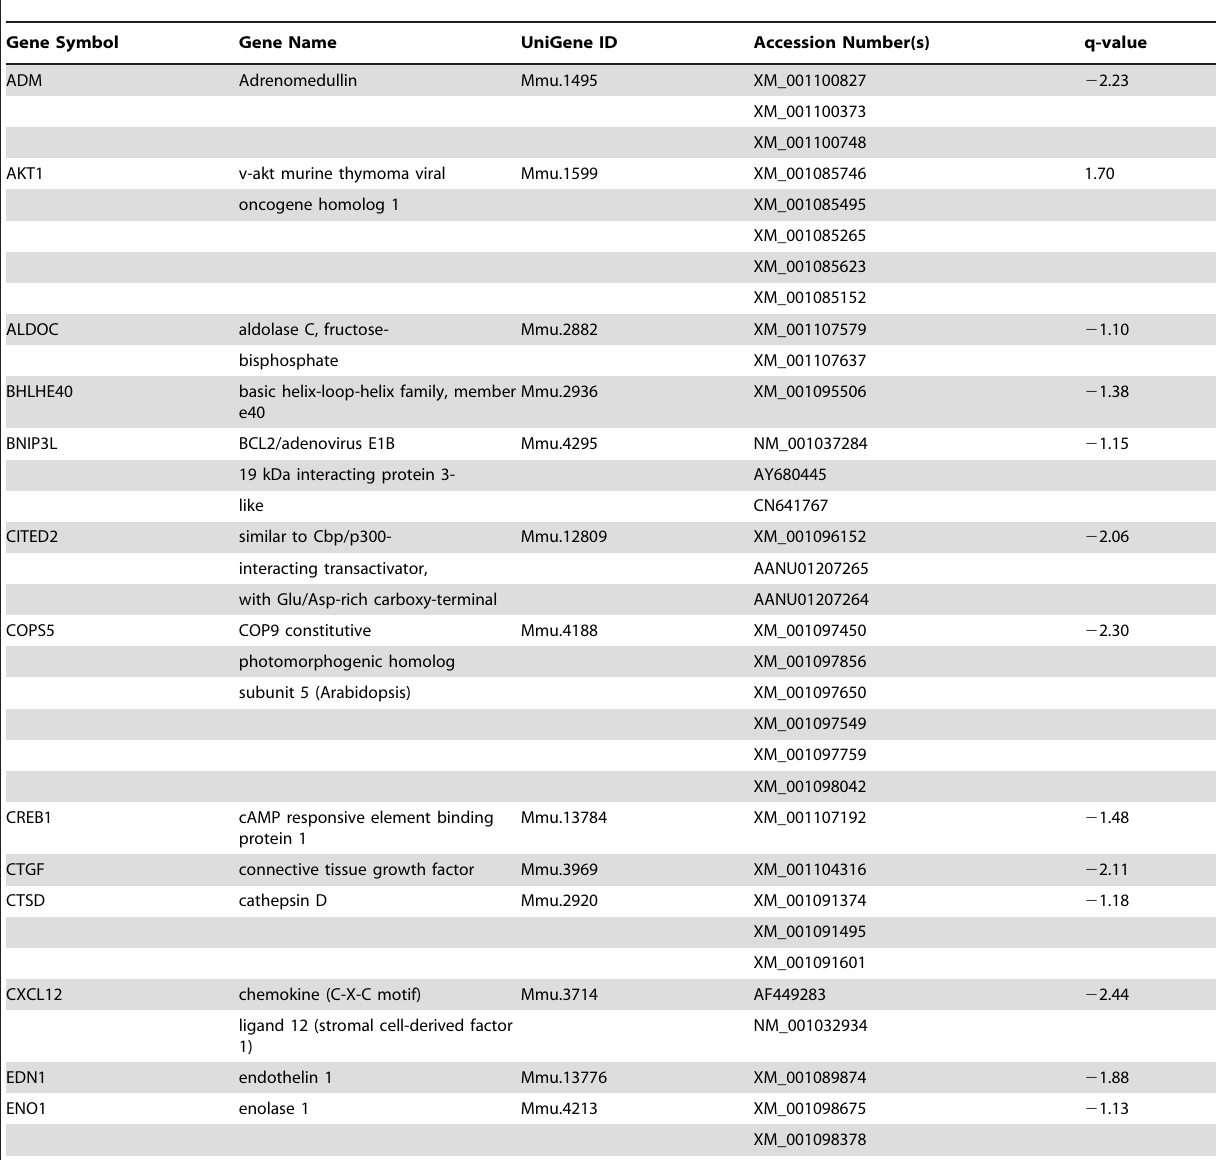
Table 5. Oxygen-regulated genes displaying differential expression between rhesus ESC generated from in vivo derived or in vitro cultured embryos compared with published